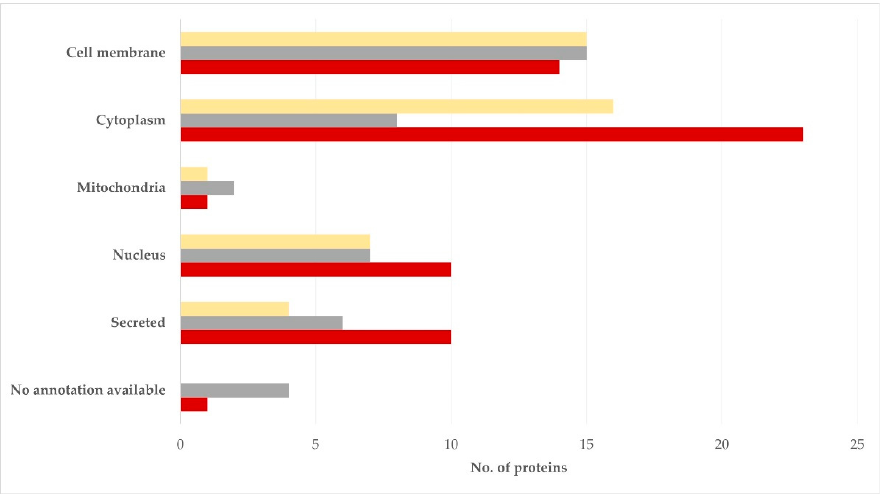
Figure 4. Subcellular location of proteins detected in blood plasma (dark red), semen sperm-rich fraction (grey), and semen prostatic fraction (yellow) from dogs were involved (protein identification by LC-MS/MS).